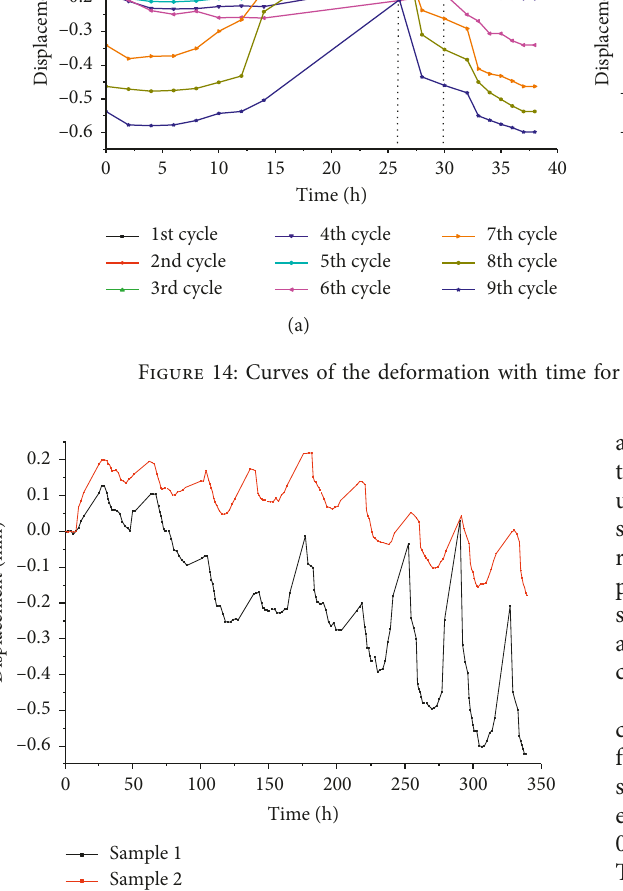
Figure 15: Curves of the total deformation with time for sample 1 and sample